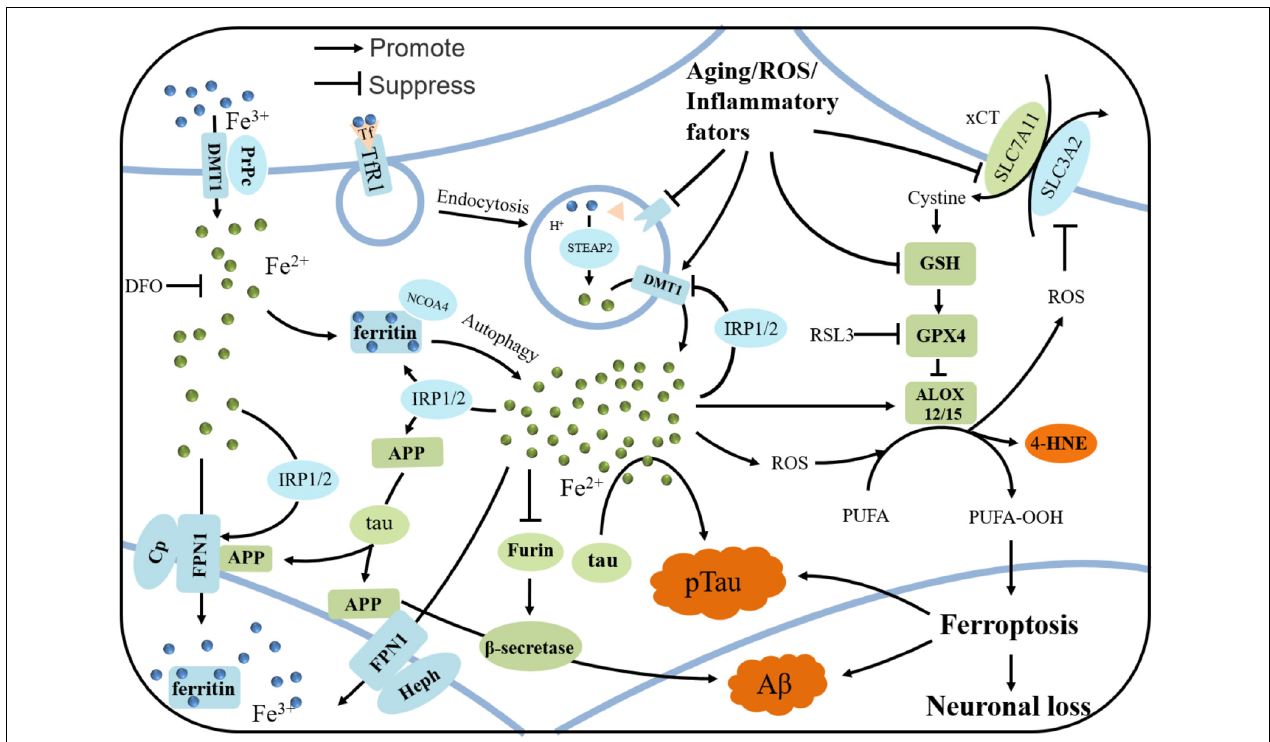
FIGURE 1 | The iron regulation in neuron and the mechanism of ferroptosis in AD. Iron is uptaken by neurons via holo-Tf/TfR1 complex or DMT1/PrPC-dependent manners. PrPC reduce Fe 3 + to Fe 2 + and DMT1 transport Fe 2 + into neurons. Tf carrying Fe 3 + forms a complex with TfR1, and enters neurons via clathrin-mediated endocytosis. Fe 3 + detaches from Tf and then is reduced by STEAP3. Fe 2 + is pumped to cytoplasm by DMT1, and is stored in ferritin in the form of Fe 3 + when overload. In some conditions, ferritin undergoes autophagy by binding with NCOA4, releasing iron and subsequently leading to lethal iron levels and ferroptosis. Elevated irons could be excreted by FPN1/Cp or FPN1/Heph, with the assistance of APP, which is transported to stabilize FPN1 by soluble tau protein. Aging, inflammation, and oxidative stress could dysregulate the iron transport proteins and cause iron retention. When overload, iron could upregulates the expressions of ferritin, FPN1, and APP by IRP-IRE interactions, while suppresses the normal function of furin, leading to the upregulation of β -secretase and thus accelerating A β deposition. When xCT or GSH decreases in the neurons under some states, the decreased GPX4 cannot exert the function of anti-lipid peroxidation. After Fenton reaction or ALOX-catalyzed process, PUFA-OOH can accumulate to a lethal level to trigger ferroptosis, which could be responsible for the tau hyperphosphorylation, A β formation and neuronal